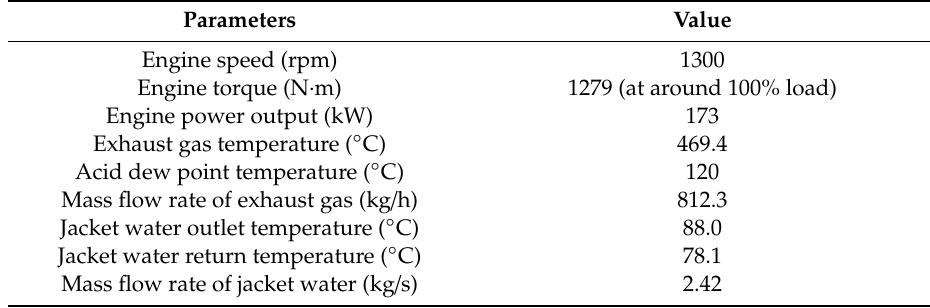
Table 3. Parameters of the engine and waste heat sources under the design conditions.